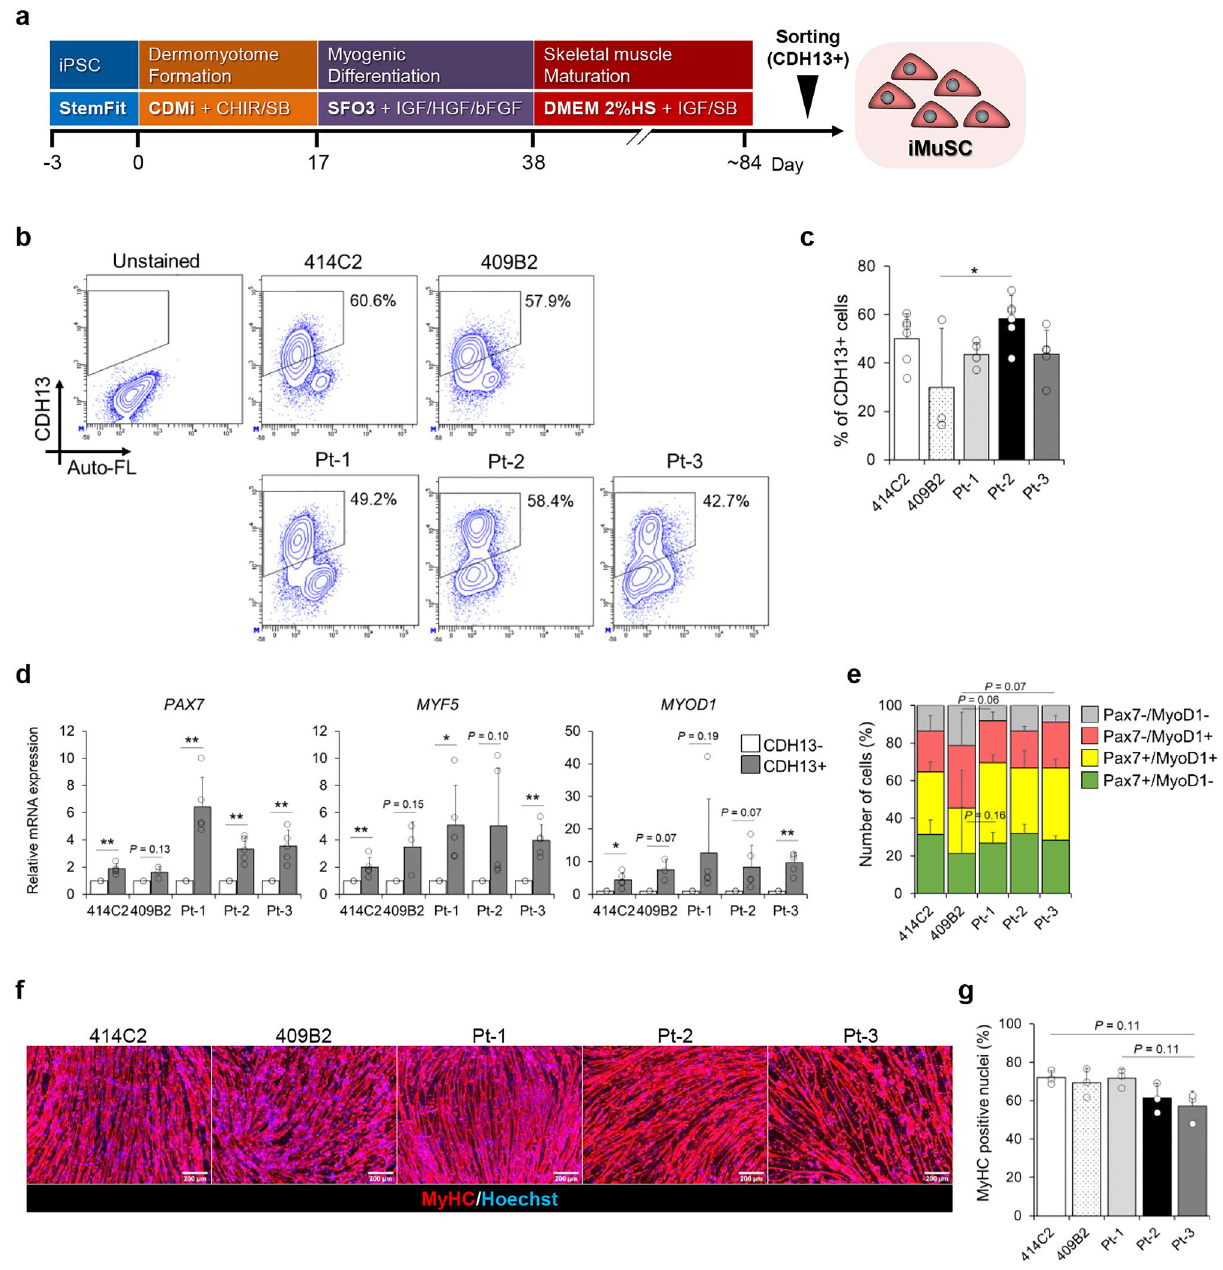
Figure 5. Myogenic induction of hiPSCs and evaluation of the myogenic capacity of CDH13-positive iMuSCs in vitro. ( a ) A schematic stepwise protocol for transgene-free differentiation for 13 weeks with reference to our previous report 20 . ( b and c ) Flow-cytometric analysis of CDH13 at week 12–13 of differentiation. ( b ) Representative images of flow-cytometry analysis of 414C2, 409B2, Pt-1, Pt-2, and Pt-3 cells for CDH13 expression. ( c ) Quantitative analysis of the CDH13-positive cells by flow cytometry. Data represent the means + SD of at least three independent experiments and were analyzed by one-way ANOVA followed by Tukey’s test (* P < 0.05). ( d ) mRNA expressions of the myogenic markers PAX7 , MYF5 and MYOD1 in the sorted CDH13-negative and -positive cells by RT-qPCR analysis after sorting. The gene expressions are indicated by relative values to the CDH13-negative group in each cell line. Data represent the means + SD of at least three independent experiments and were analyzed by Welch’s t-test (* P < 0.05, ** P < 0.01). ( e ) Quantitative analyses of Pax7 + , MyoD1 + , and Pax7 + MyoD1 + cells in the sorted CDH13-positive cells by immunocytochemistry. Data represent the means + SD of at least three independent experiments and were analyzed by one-way ANOVA followed by Tukey’s test. ( f and g ) Evaluation of the differentiation efficiency of the CDH13-positive iMuSCs in vitro on day 7. ( f ) Representative immunohistochemistry images for MyHC and Hoechst. Scale bars, 200 μm. ( g ) The differentiation efficiency calculated by determining the percentage of Hoechst-positive counts (nuclei) in the MyHC-positive area. Data represent the means + SD of three independent experiments and were analyzed by one-way ANOVA followed by Tukey’s